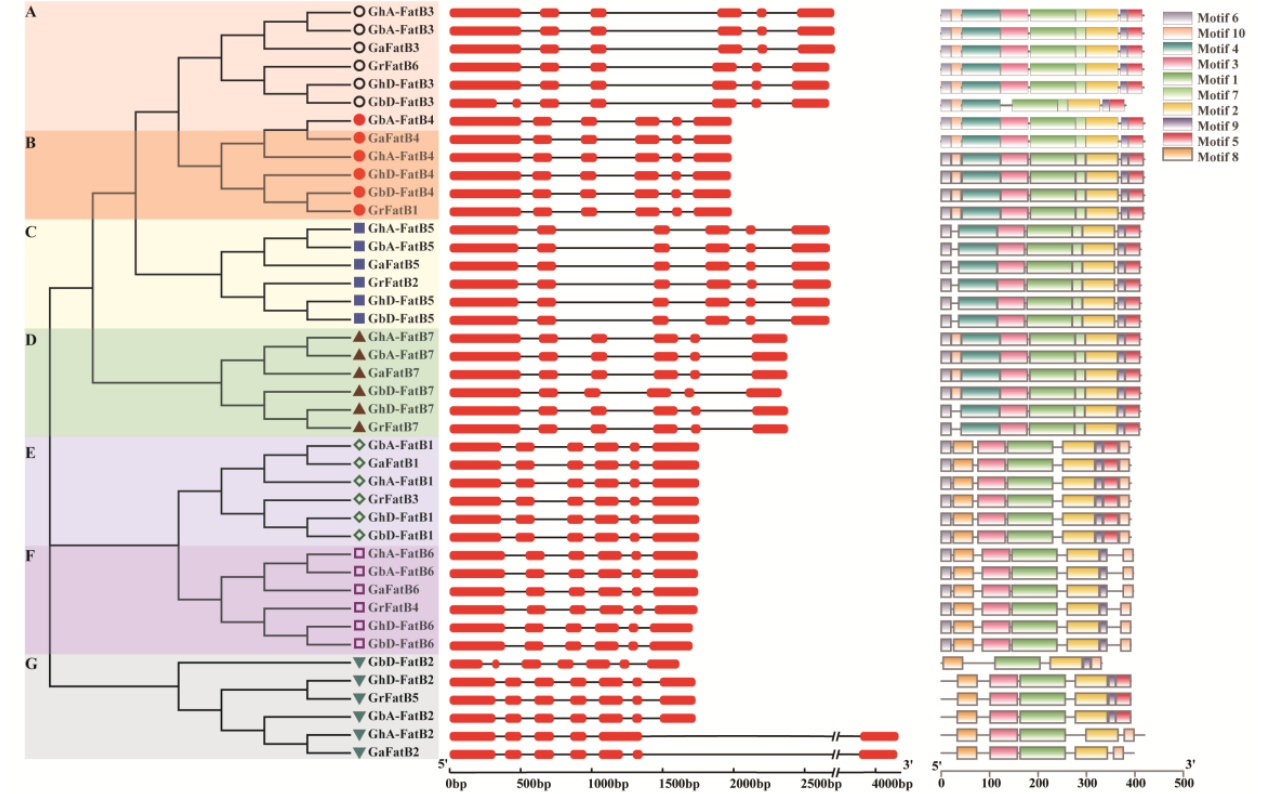
Figure 2. Gene structure and conserved motifs of FatBs in four cotton species ( G. arboreum , G. raimondii , G. barbadense and G. hirsutum ). “A~G” represent different FatB subfamilies. Blue blocks represent GhFatBs of G. hirsutum . Gene structure and conserved motifs are predicted by an online website of GSDS (http://gsds.cbi.pku.edu.cn/) (accessed on 12 October 2021) and MEME (http://meme-suite.org/ index.html) (accessed on 12 October 2021), respectively. The exons and introns regions are displayed by red boxes and block lines, respectively. Motif 1, 2 and 3 are displayed with amino acid sequences. Each color represents an amino acid. The size of the letter represents the conservation of the amino acid at the corresponding position. The larger the letter, the stronger the